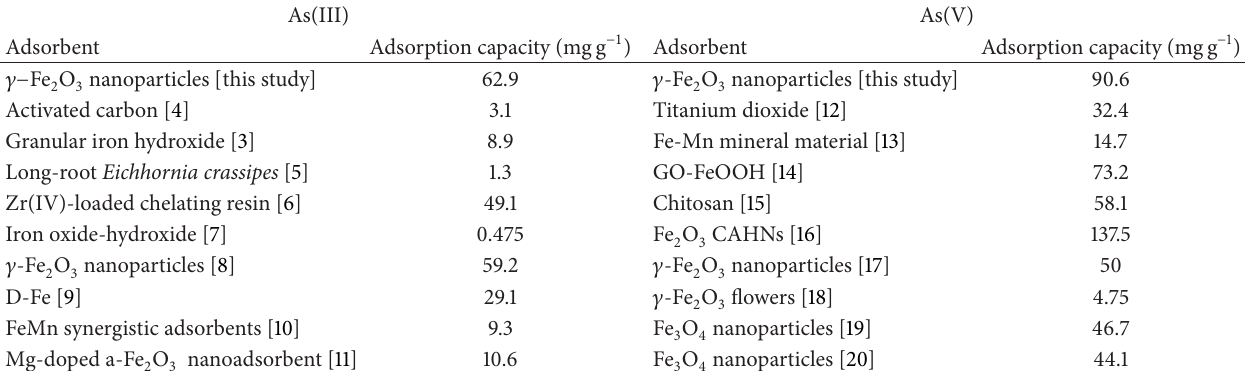
Figure 4: Time-dependent concentration of As(III) (initial concentration of 100mg L −1 ) and As(V) (initial concentration of 100 mgL −1 ) over 𝛾 -Fe 𝛾 -Fe 2 O 3 (a) and adsorption isotherms of As(III) and As(V) on 2 O 3 . Table 1: The adsorption capacities of some typical